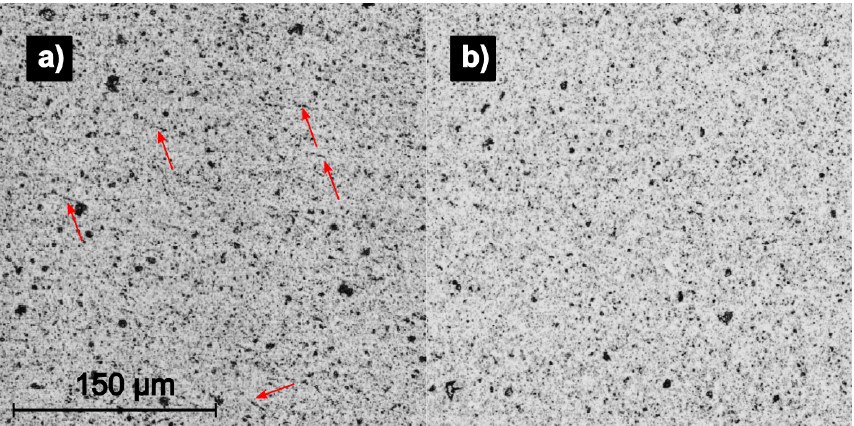
Figure 16. SAM micrographs showing the surface composition of: ( a ) brittle material removal milled; ( b ) ductile cutting regime milled. Red arrows point out self-closed cracks in the